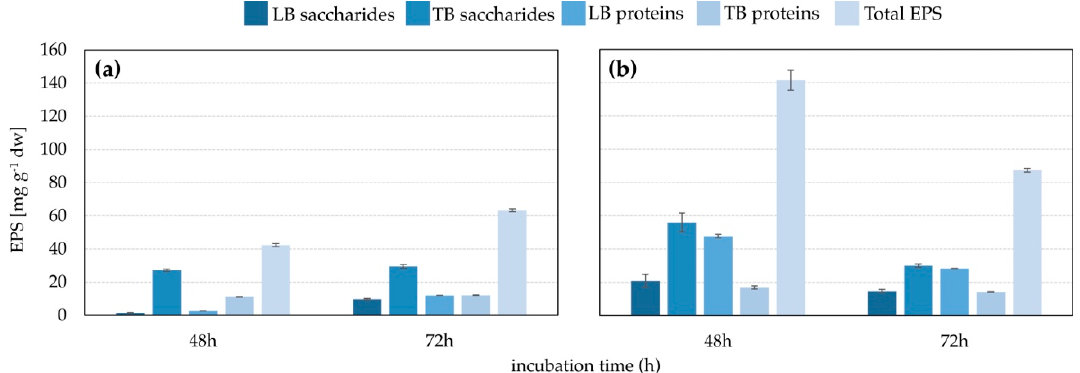
Figure 2. EPS production as a function of incubation time by S. plymuthica strain SC3I(2) ( a ) and S. plymuthica strain As3-5a(5) ( b ).